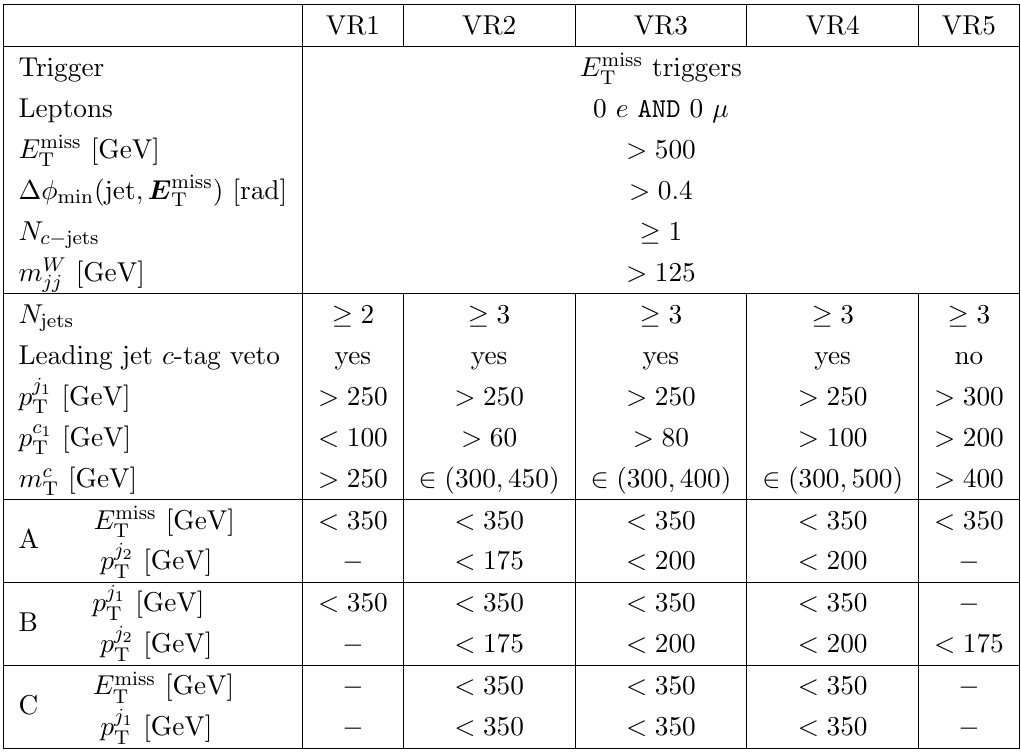
Table 5 . Overview of the validation region selection criteria. N jets and N c (cid:0) jets indicate the total number of jets and c -jets, respectively; p j 1 and p j 2 indicate the transverse momentum of the leading T T and sub-leading jet; and p c 1 is the transverse momentum of the c -jet with the highest p T T